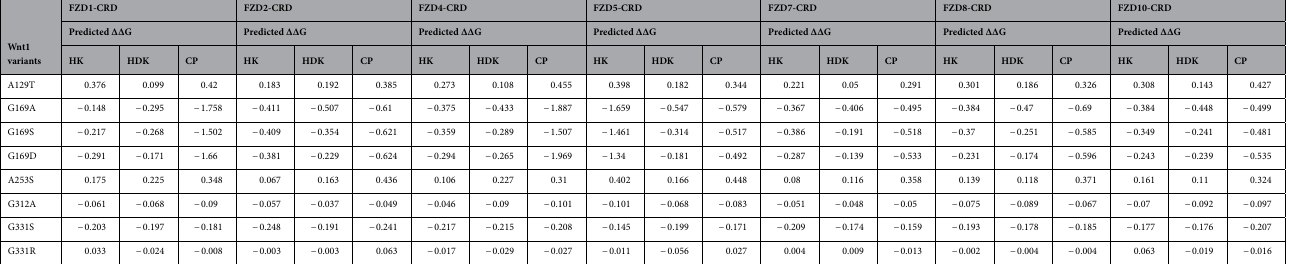
Table 5. Impact of 8 highly destabilizing variants on the binding interface of Wnt1-FZD-CRDs complex as predicted by mCSM server. Wnt1-FZD-CRDs complexes were obtained from HADOCK, HADDOCK